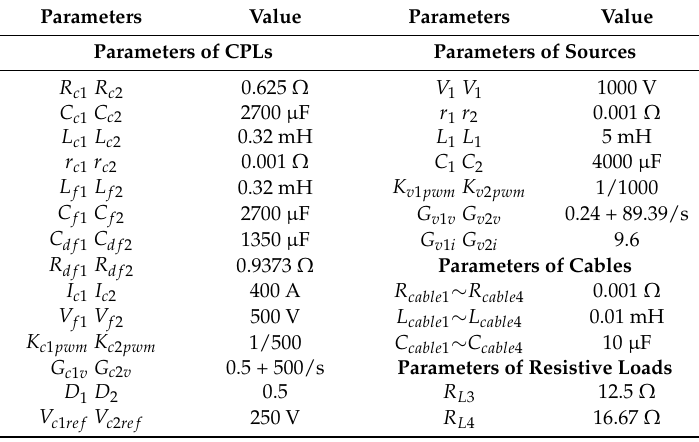
Table B1. Main electrical parameters of the studied DC meshed distributed power systems